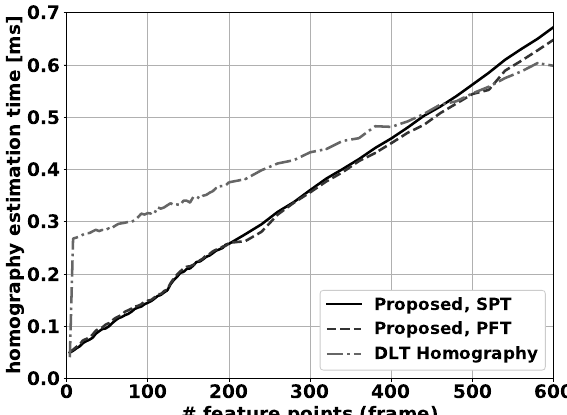
Figure 8. Average homography calculation time per frame, as a function of the number of feature points used in the calculation.